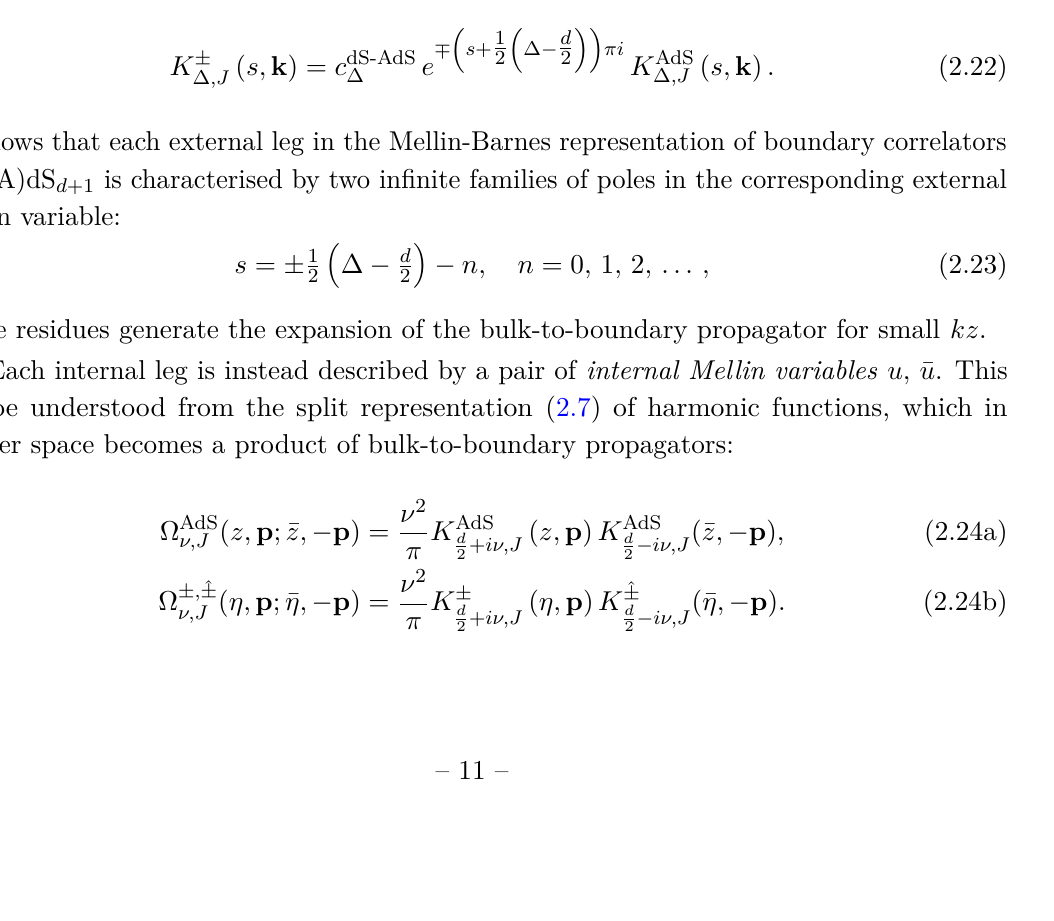
where k = | k | . At the level of the Mellin-Barnes representation the relation (2.14)